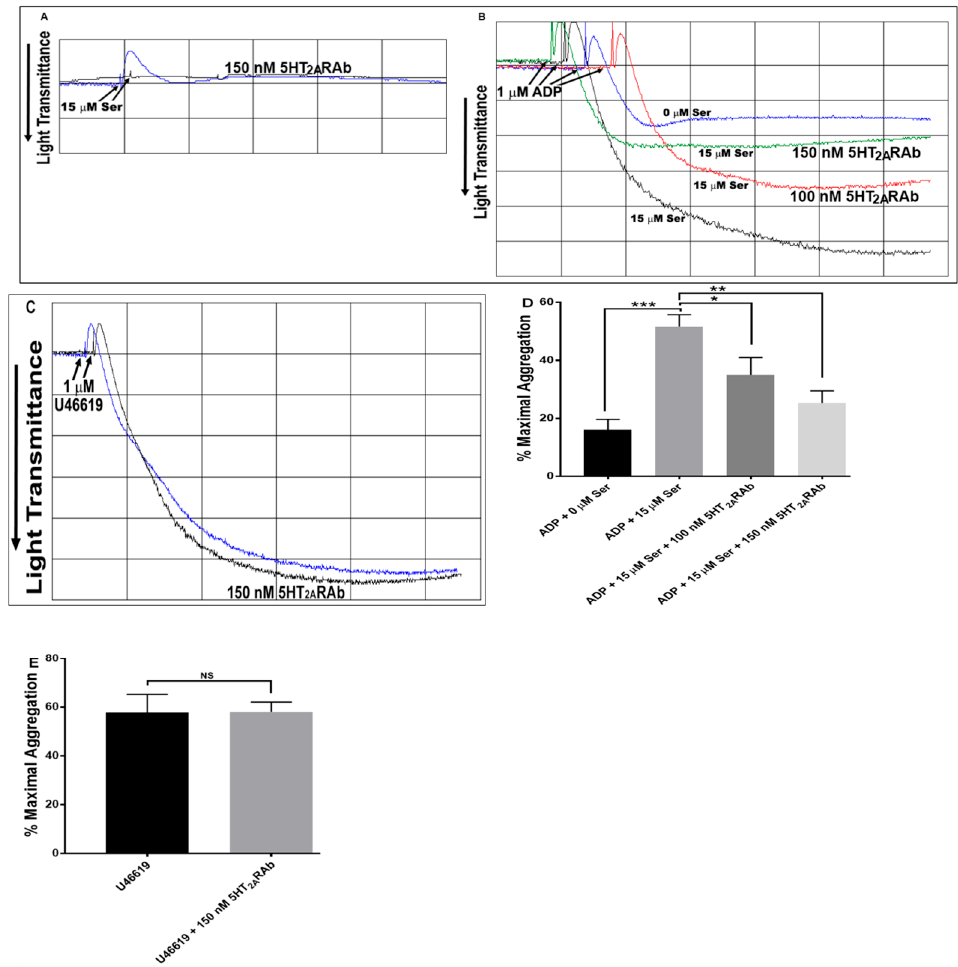
Figure 3. The 5HT 2A RAb inhibits serotonin-enhanced ADP-induced mouse platelet aggregation ex vivo. Mouse PRP obtained from either vehicle- or 5HT 2A RAb-injected mice (100–150 nM), once daily for 5 days was stimulated with 15 µ M serotonin ( A ), a submaximal concentration of ADP (1 μ M) in the presence or absence of 15 µ M serotonin ( B) or with 1 µ M U46619 ( C ). ( D ) and ( E ) show quanti- fication of the maximum aggregation data in ( B ) and ( C ) respectively. (* p < 0.05; ** p < 0.01; *** p < 0.001; NS, nonsignificant). Each experiment was repeated three times, with blood pooled from 6–8 mice each time.